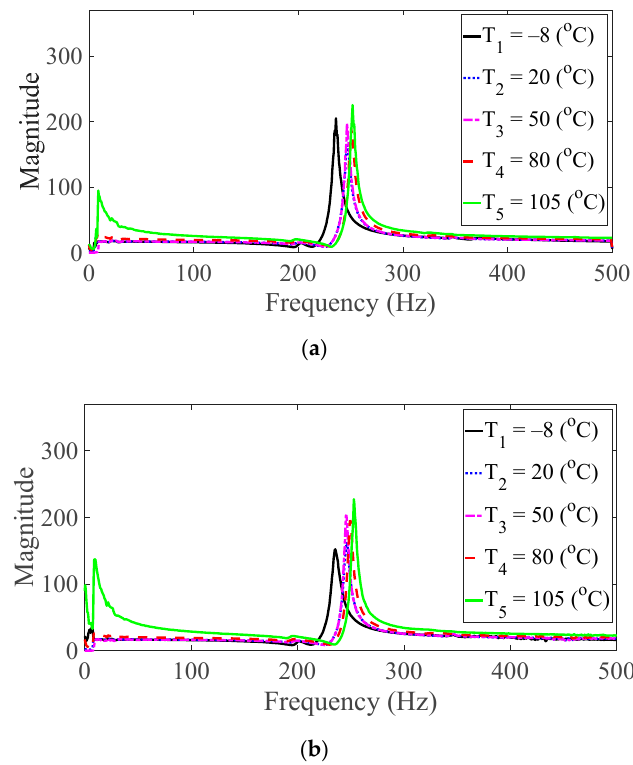
Materials 2019 , 12 , x Figure 5. Measured FRFs with θ = 0°: ( a ) p = harmonic and ( b ) p = random. Figure 5. Measured FRFs with θ = 0 ◦ : ( a ) p = harmonic and ( b ) p = random.